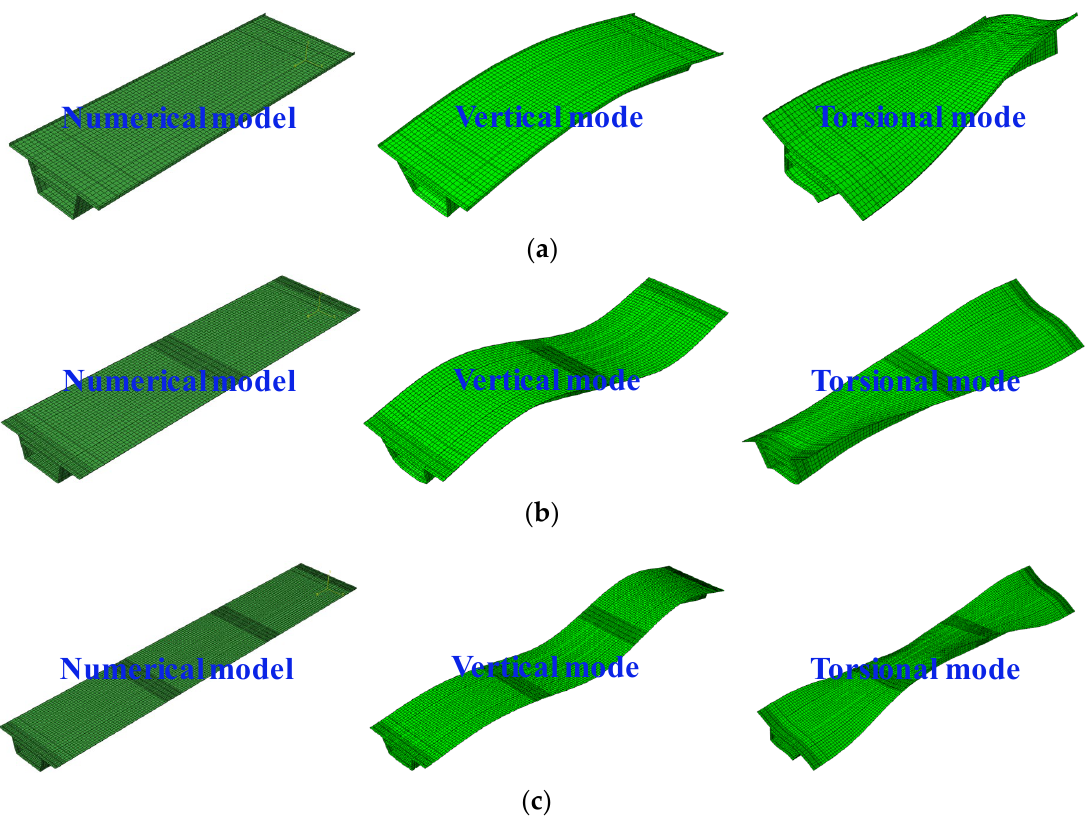
Figure 7. Numerical models of the target bridges using a commercial finite element analysis program: ( a ) Imgi 2nd Bridge; ( b ) Maeaji Bridge; ( c ) Hwalchun Bridge.